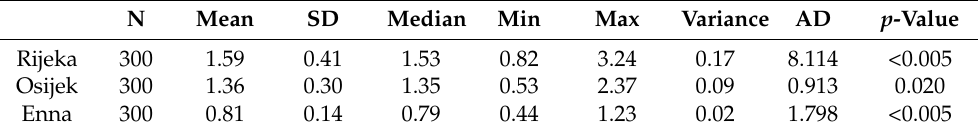
Table 9. Descriptive Statistics of Databases and Anderson-Darling test results.